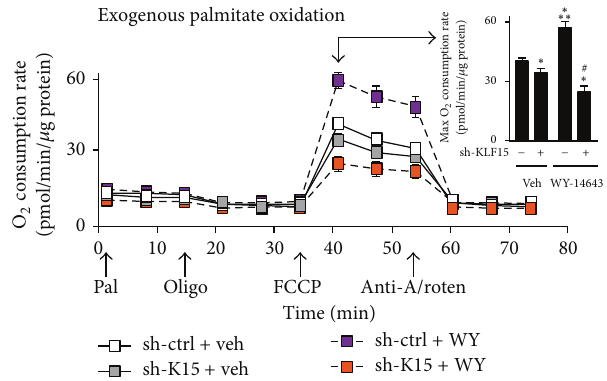
Figure 5: Ligand induced PPAR 𝛼 lipid oxidation is KLF15 depen- dent. Oxygen consumption rate (pmol/min) in neonatal rat ven- tricular cardiomyocytes after sh-RNA mediated Klf15 silencing in the absence or presence of the PPAR 𝛼 -specific ligand WY-14,643 (10 𝜇 M, 24 hrs). Arrows along 𝑥 -axis indicate acute addition of BSA-conjugated palmitate (Pal, 150nM), ATP synthase inhibitor oligomycin (Oligo, 2.5 𝜇 g/mL), uncoupler FCCP (1.5 𝜇 M), complex III inhibitor antimycin A (4 𝜇 M)/complex I inhibitor rotenone (2 𝜇 M) (Anti-A/Roten). Inset : maximal oxygen consumption rate at t = 40min following addition of uncoupler FCCP ( n = 6–9). ∗ 𝑃 < 0.05 versus vehicle. ∗∗ 𝑃 < 0.05 versus sh-KLF15. # 𝑃 < 0.05 versus WY-14643. Values normalized to total cellular